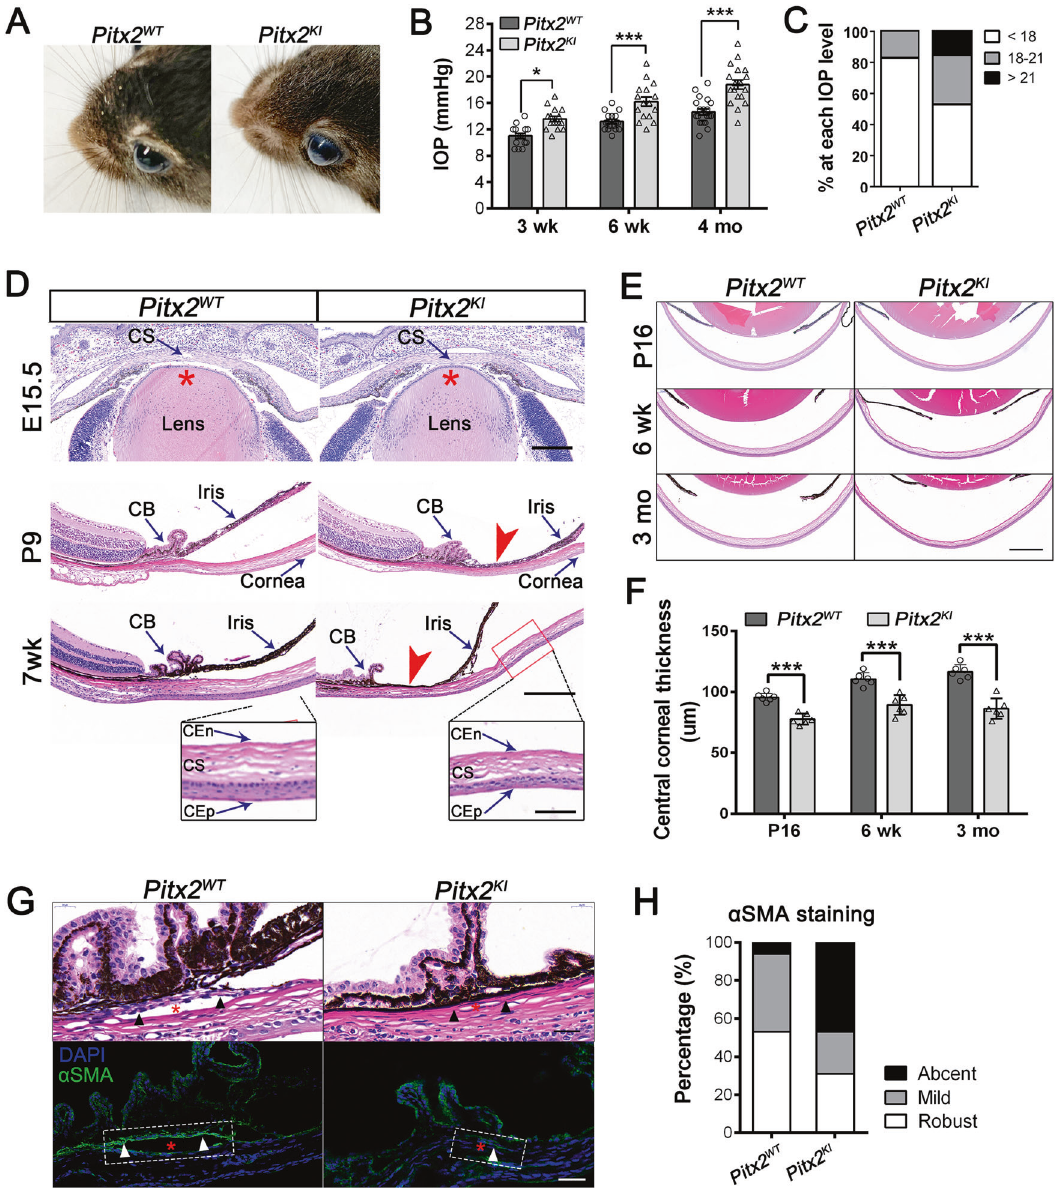
Fig. 3 Elevated intraocular pressure and hypoplasia of ocular anterior segment in Pitx2 KI mice. A Image of Pitx2 WT and Pitx2 KI adult mice at 4 months of age. B Intraocular pressure analysis in the Pitx2 WT and Pitx2 KI mice at 3 weeks ( n = 16), 6 weeks ( n = 16) and 4 months ( n = 18) of age. Individual IOP values were shown as dots in the histogram. C Histogram showing the proportion of eyes in each IOP range at 4 months. D Hematoxylin and eosin (H&E) staining of eyes of Pitx2 WT and Pitx2 KI mice at E15.5, P9, and 7 weeks. Compared with Pitx2 WT mice, anterior- segment development in E15.5 Pitx2 KI mice was slightly impaired. Scale bars: 100 μ m. Iris-cornea adhesion and closed iridocorneal angle (red arrows) were detected in mutant mice at P9 and 7 weeks of age. Scale bars: 200 μ m. The bottom panels show high-magni fi cation images of the boxed areas, which denotes a thinner corneal epithelium in Pitx KI mice at 7 weeks. Scale bars: 50 μ m. CB, ciliary body; CEn, corneal endothelium; CEp, corneal epithelium; CS, corneal stroma. E H&E-stained sagittal sections of E15.5, P9, and 7 weeks old WT littermates and mutant samples. Scale bars: 200 μ m. F A comparison of central corneal thickness between mutants and their WT littermates ( n = 6 in each group). Mutant mice present a thinner central cornea relative to their WT littermates. Individual thickness values are shown by dots in the histograms. * P < 0.05; *** P < 0.001. Data are presented as mean ± SEM. G Position-matched images of the H&E staining (upper panel) and the immuno fl uorescent staining (lower panel) of optic sagittal sections are shown. Trabecular meshwork (TM) is labeled with alpha-smooth muscle actin ( α -SMA), and nuclei counter-stained with DAPI. Conventional out fl ow tissues are outlined by white boxes. Asterisks indicate Schlemm ’ s canal (SC) lumen, arrowheads show trabecular meshwork. Scale bars: 25 μ m. H Data show the percentage of α -SMA staining measurements in the boxed TM region. Staining was assessed by ratings of “ robust ” , “ mild ” , or “ absent ” . ( n = 6 in each group). * P < 0.05; *** P < 0.001. Data are presented as mean ± mutants (Fig. 4C). RGC density was further examined with anti- (Fig. S6A, C), indicating signi fi cant RGC loss. This result was Brn3a stained retinal fl atmounts from 3-month-old animals. Each precisely con fi rmed with anti-Brn3a, an RGC-speci fi c marker, anti-Brn3a stained retinal fl atmount was segmented into nasal, stained retinal section from 6-week-old (Fig. 4A) and 3-month- temporal, ventral, and dorsal quadrants, and RGC density old (Fig. 4B) mice, which demonstrated a progressive RGC death in